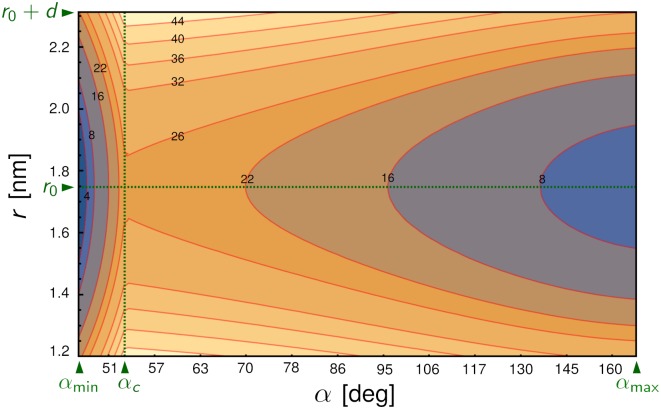
Energy landscape of the Hamiltonian U from Eqs (1) and (2) in terms of r and α = π − θ − ϕ at force F = 0, with the parameters given in Table 1 and described in the text.Energy contour labels are in units of kBT. The vertical dashed line corresponds to the transition angle αc, the horizontal dashed line to the natural bond length r0, and the top edge to the distance r0 + d beyond which the bond ruptures. The energy barriers to rupture are smaller in the region α ≤ αc on the left, relative to the region α > αc on the right. Since applied force F > 0 tilts the landscape toward larger inter-domain angles α, the mean bond lifetime will initially increase with force.